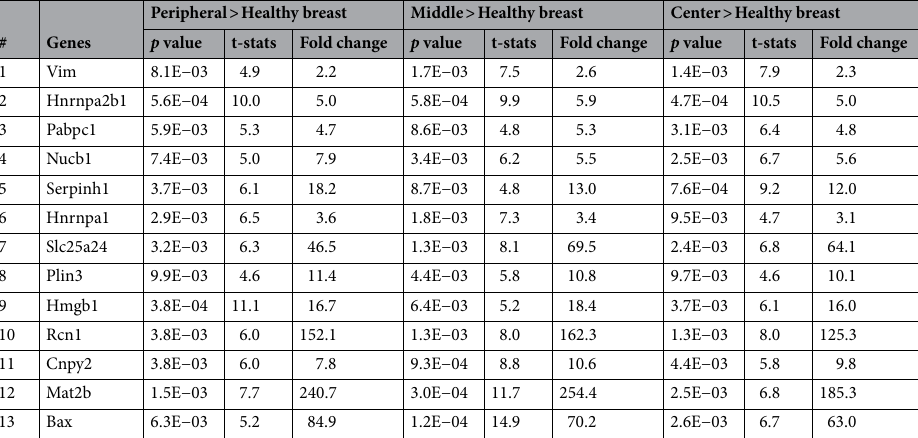
Table 1. List of proteins extracted with e-biopsy that differentiate 4T1 tumor from healthy breast tissue samples for all tumor sampling locations. This is a list of genes that are overexpressed in all 3 tumor locations together (Center/Midway/Peripheral; with both tumor location replicas averaged into a single value) compared to healthy breast samples (paired t-test p value < 0.01 at each location). A two-sided, paired t-test was applied to each of the 4,519 known proteins sampled from 5 mice via e-biopsy. No underexpressed proteins were identified using the same criterion, namely p < 0.01 in all three